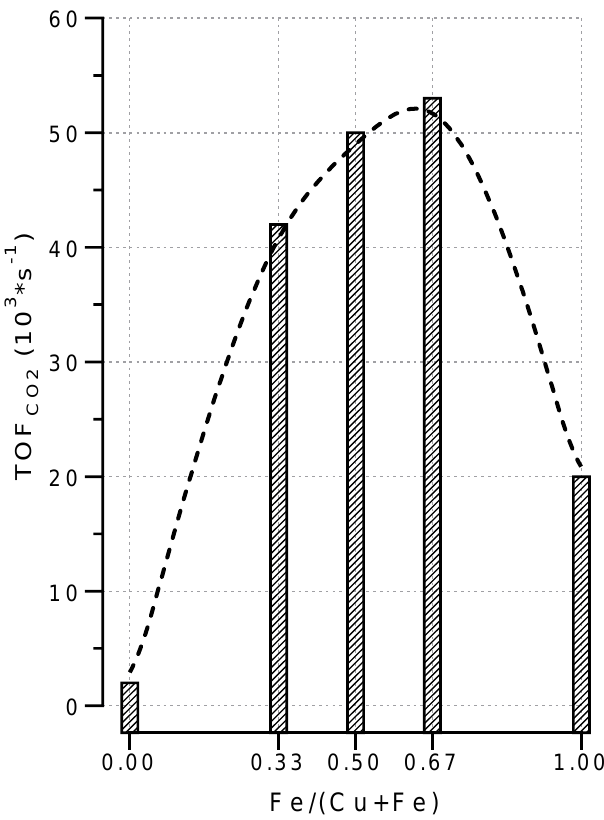
Figure 8. Turnover frequency of CO 2 conversion on oxygen vacancies. Experimental data calculated at 30 bar and 220 °C (X CO2 < 5%).